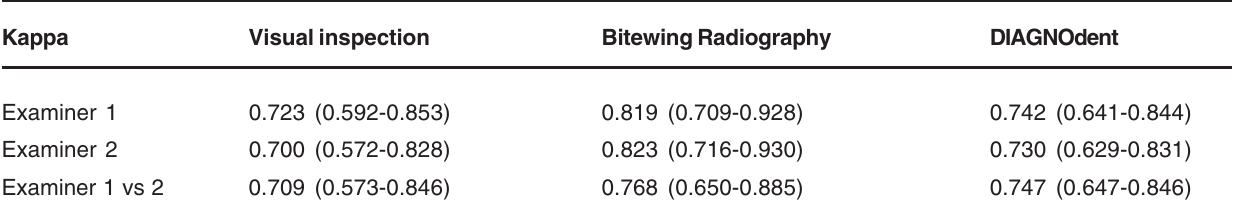
TABLE 4- Kappa value of inter- and intra-examiner repeatability for each diagnostic system (95% confidence intervals in